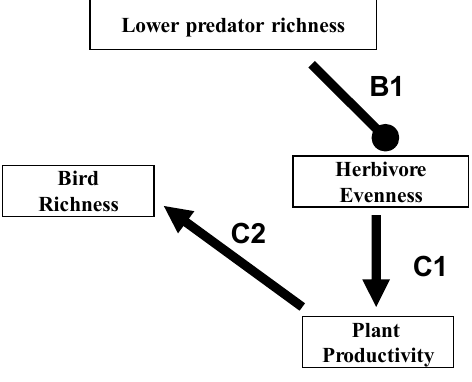
Figure 4. A bottom-up diversity cascade in an insect food web [99]. In this system, plant quality affected aphid size and density, which had direct and indirect effects on parasitoid and secondary parasitoid richness and evenness. The diversity cascade represented by the pathways (C1, B1, A1) is one example of the strong effects of subtle changes in resource quality that can accompany changes in plant diversity. Not all measured effects from the study are shown in the